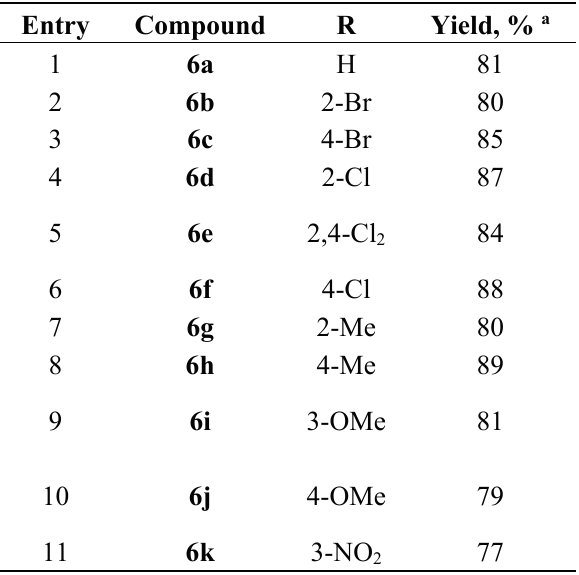
Table 2. Scope of the synthesis of compounds 6 .